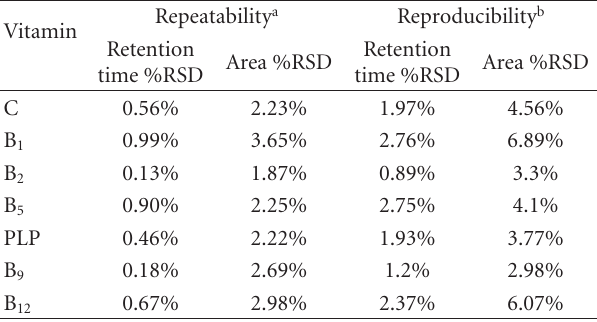
Table 5: Retention times and peak areas of analysed vitamins. Relative standard deviations (%RSD) of retention times and peak plasma obtained in the analysis for repeatability and